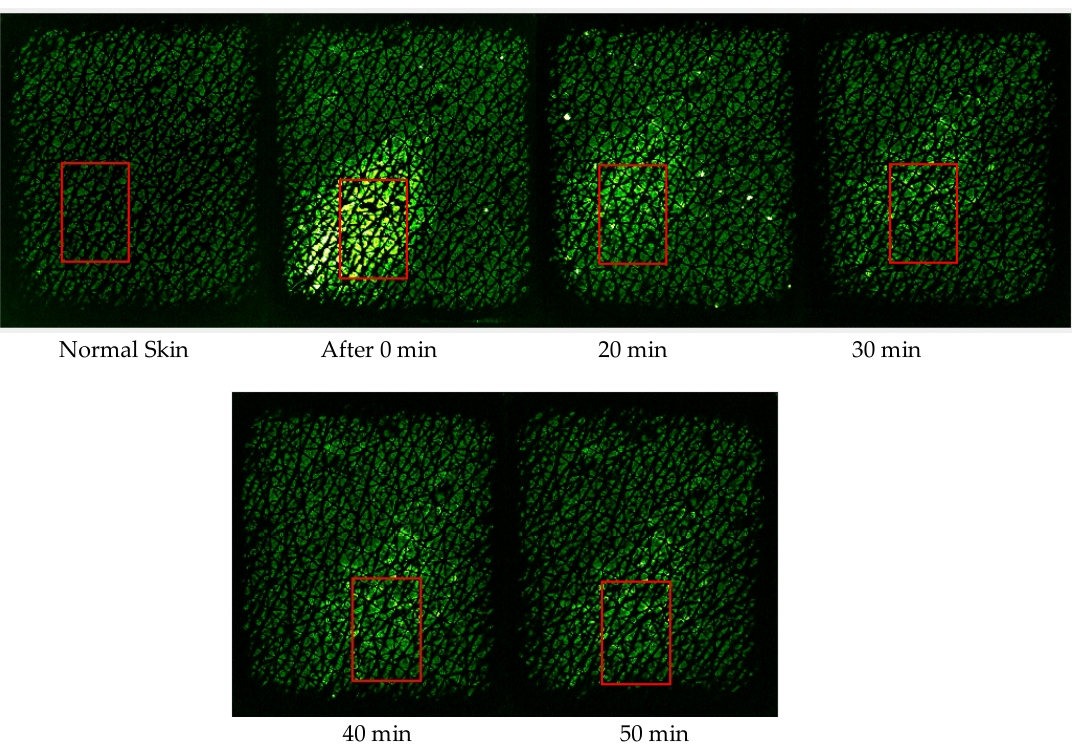
Figure 3. Capacitive contact images of skin before and after Glycerol application. Red squares show the repositioning of the RoI in Normal Skin image (before application) and in the consequent images (after application).